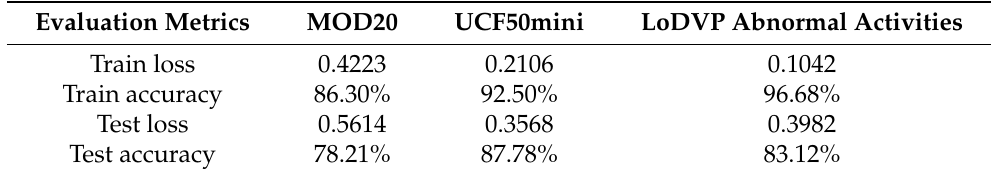
Table 2. The accuracy and loss function of the model over 50 epochs, during both training and testing